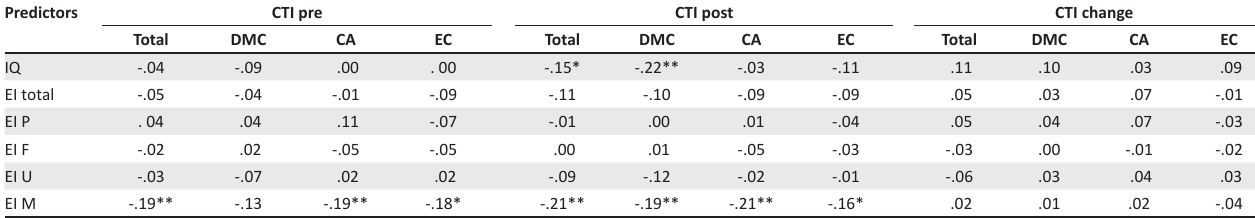
TABLE 2: Correlations between Career Thoughts Inventory (pre, post and change) scores with emotional intelligence and intelligence quotient. Predictors CTI pre CTI post CTI